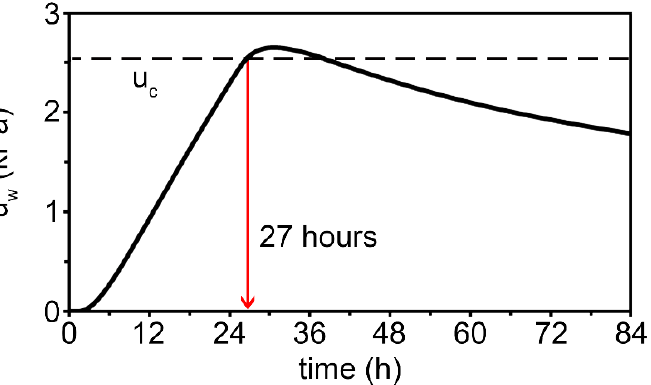
Figure 15. Evolution of the change in pore water pressure, u w , with time due to the rainfall of 5 October 2005, with indication of the critical threshold, u c , at the depth of 0.80 m.